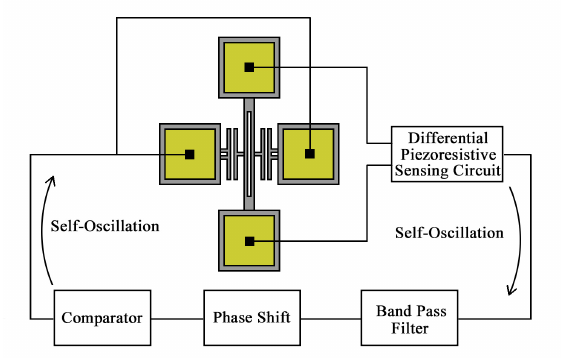
Figure 10. Micromechanical oscillator based on the DETF